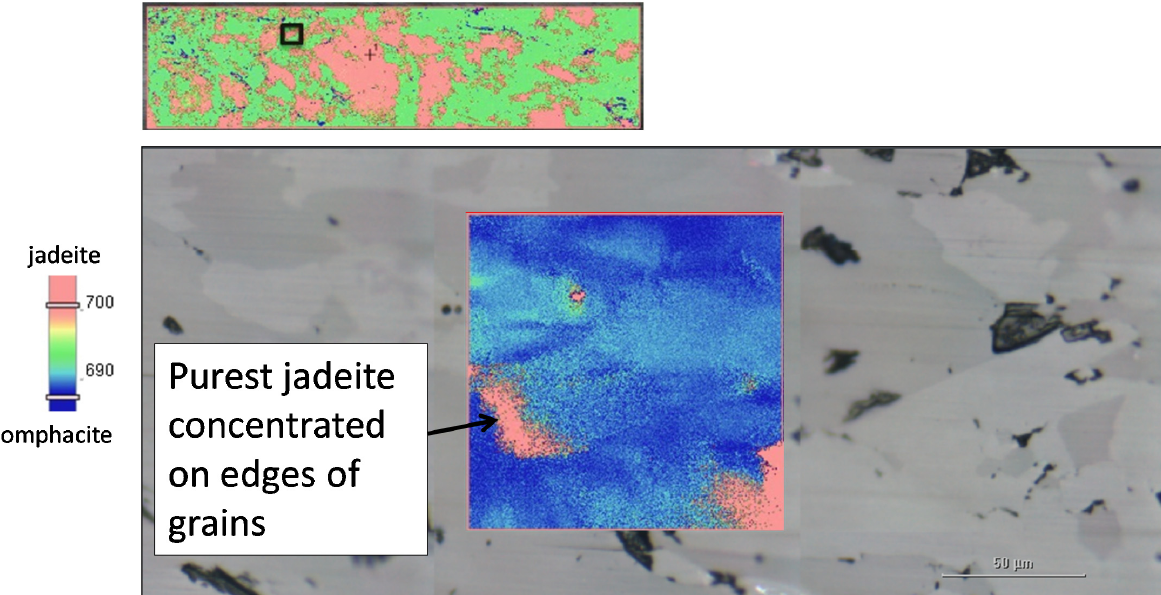
Figure 27. Raman map of a “jadeite” ring (left) shows a mixture of mineral compositions. The false color map (right) ranges in color from jadeite (pink) to omphacite (blue) based on the position of the 678–700 cm − 1 primary Raman peak.